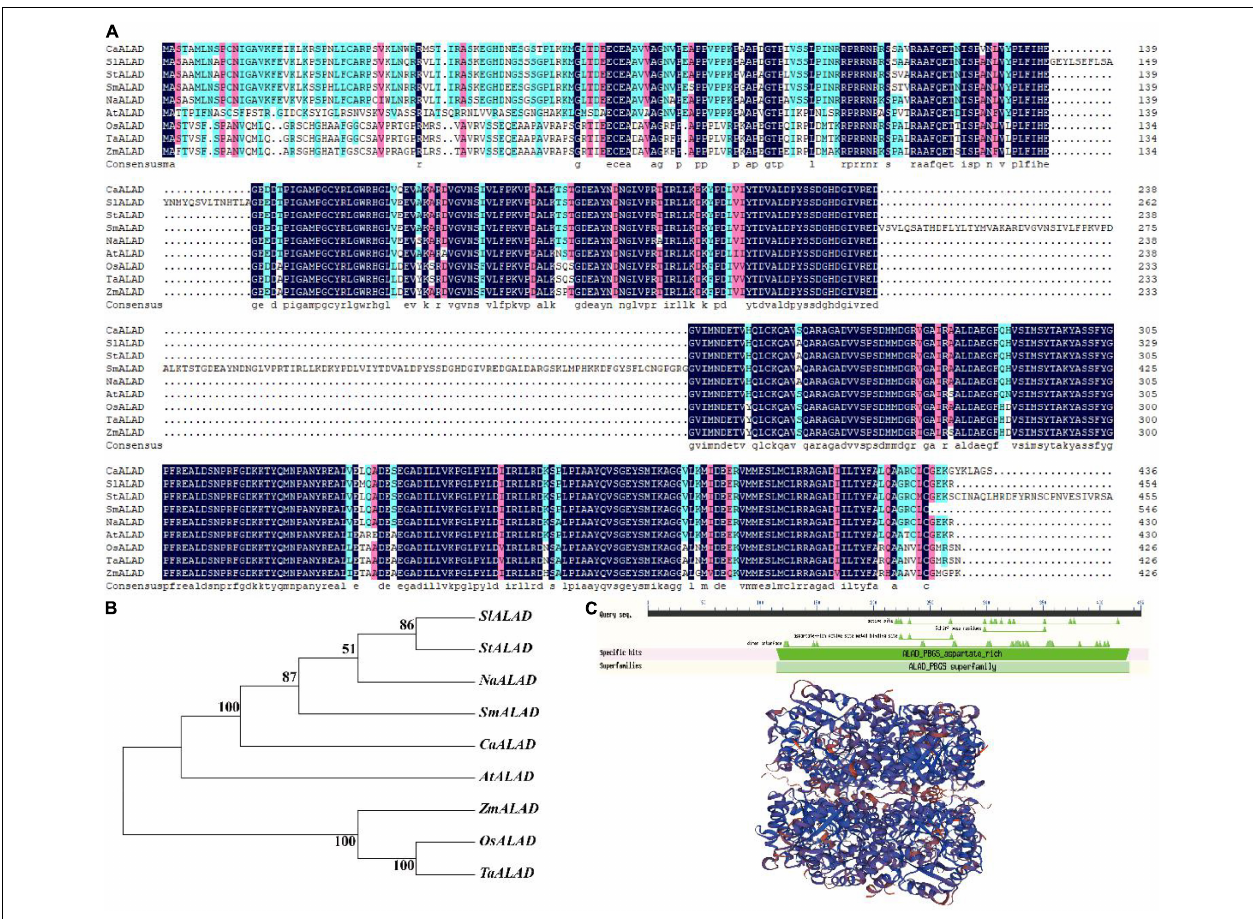
FIGURE 1 | Sequence alignment and phylogenetic relationship between CaALAD and its homologous genes from other species. (A) ALAD protein sequences alignment of the pepper ( CaALAD ), tomato ( SlALAD ), potato ( StALAD ), eggplant ( SmALAD ), tobacco ( NaALAD ), Arabidopsis ( AtALAD ), rice ( OsALAD ), wheat ( TaALAD ), and maize ( ZmALAD ). Identical residues are displayed by mazarine. (B) Phylogenetic tree of CaALAD and its homologous proteins from tomato, potato, eggplant, tobacco, Arabidopsis , rice, wheat, and maize. (C) The predicted CaALAD functional domain and tertiary